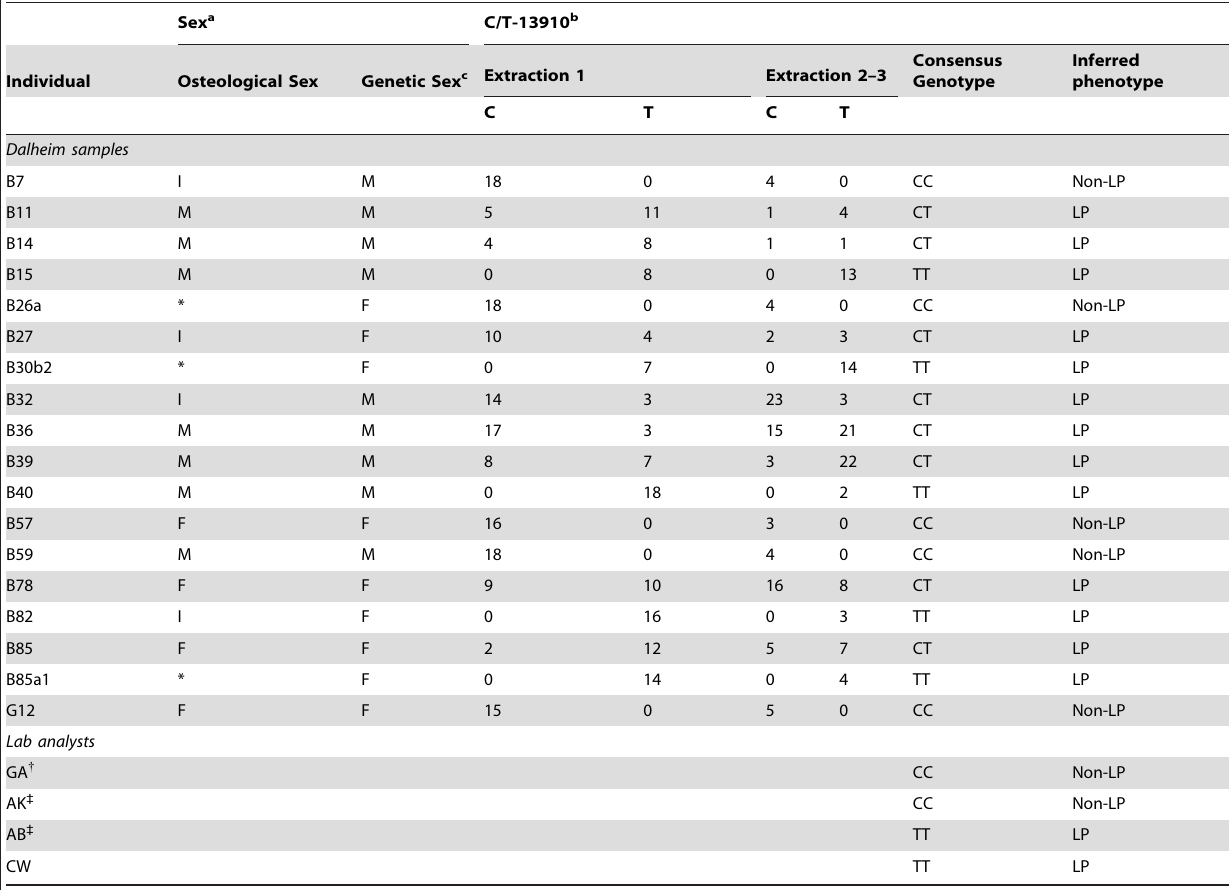
Table 2. Results of genetic sex and LP allele genotyping.